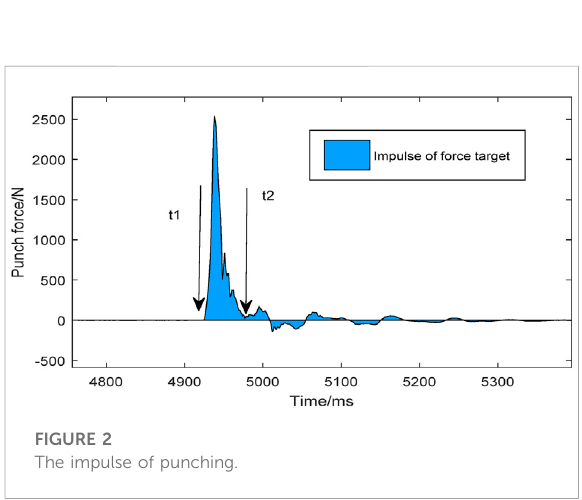
FIGURE 2 The impulse of